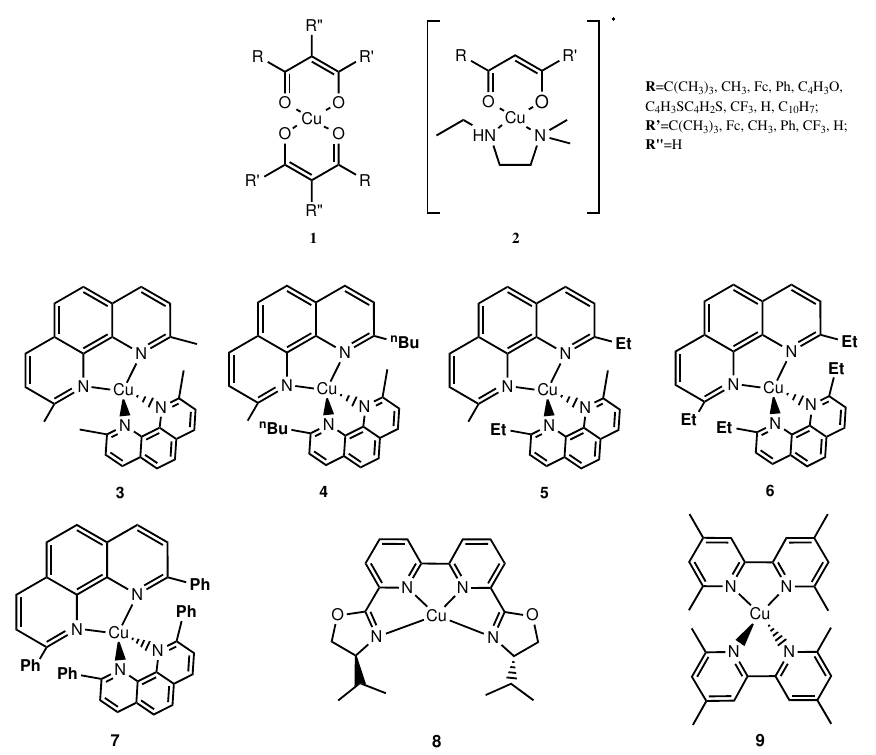
Figure 2. Examples of Cu coordination compounds envisioned for application in DSSCs. Reprinted from [17] under a Creative Commons CC-BY license and from [23] with the permission of the Royal Society of Chemistry. Table 1. Selected photovoltaic parameters of DSSCs of electrolyte/dye compositions. Reprinted from [23] with the permission of the Royal Society of Chemistry.